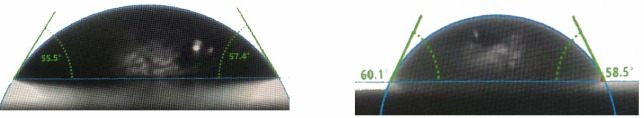
Figure 2. Contact angles of two cement slurries. ( a ) neat cement; ( b ) expansion cement. Table 1. Composition of the prepared cement samples. Constituents (Additive to Cement Ratio) (wt. Sample